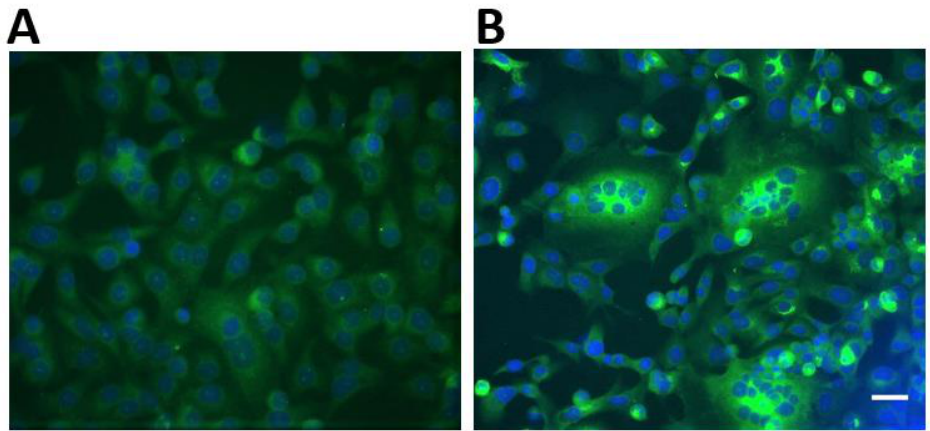
Figure 2. Recombinant immunofluorescence reactivity patterns of human MERS-CoV-positive and negative sera on Vero B4 cells used as a guide for the interpretation of livestock testing. ( A ) depicts a non-reactive sample characterized by low fluorescence intensity. ( B ) depicts a reactive sample showing high fluorescence intensity, particularly in cell syncytia. Scale bar indicates 20 μm .